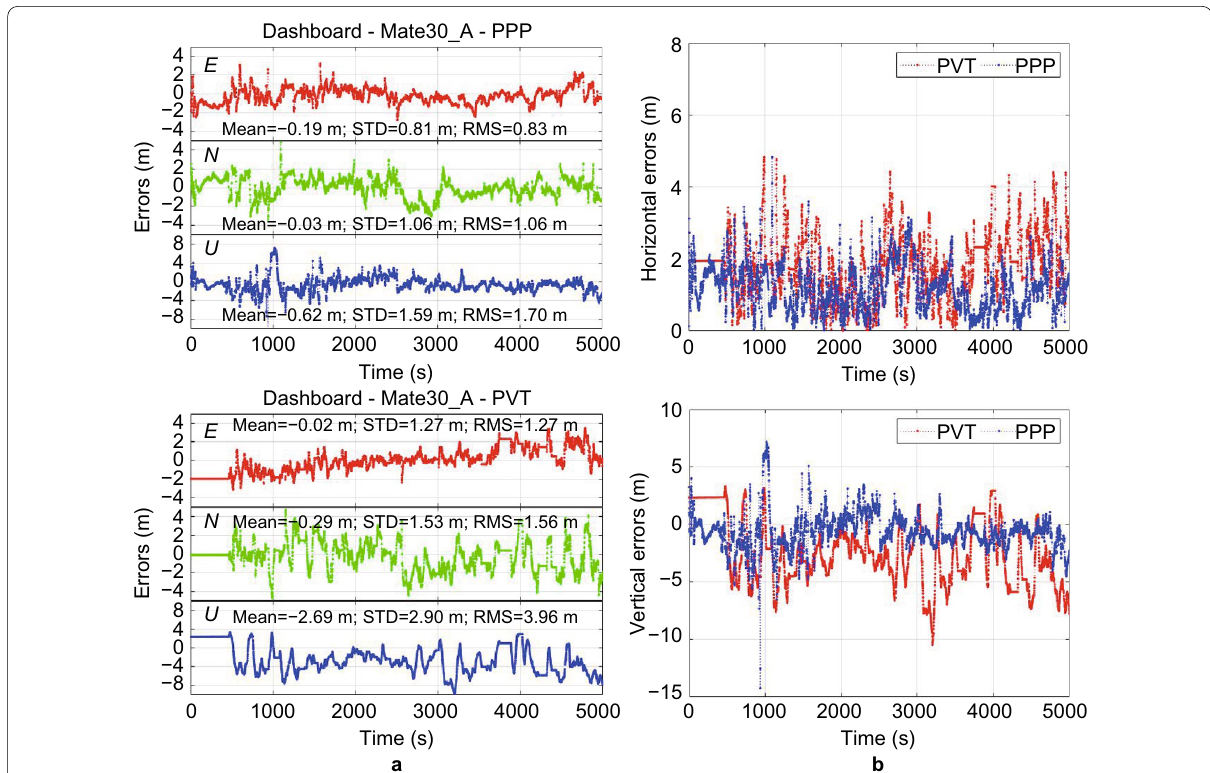
Fig. 12 The time series of the positioning errors of PPP and PVT results in a the E , N , and U components and b the horizontal and vertical directions for the Mate30_A smartphone in the dashboard mode